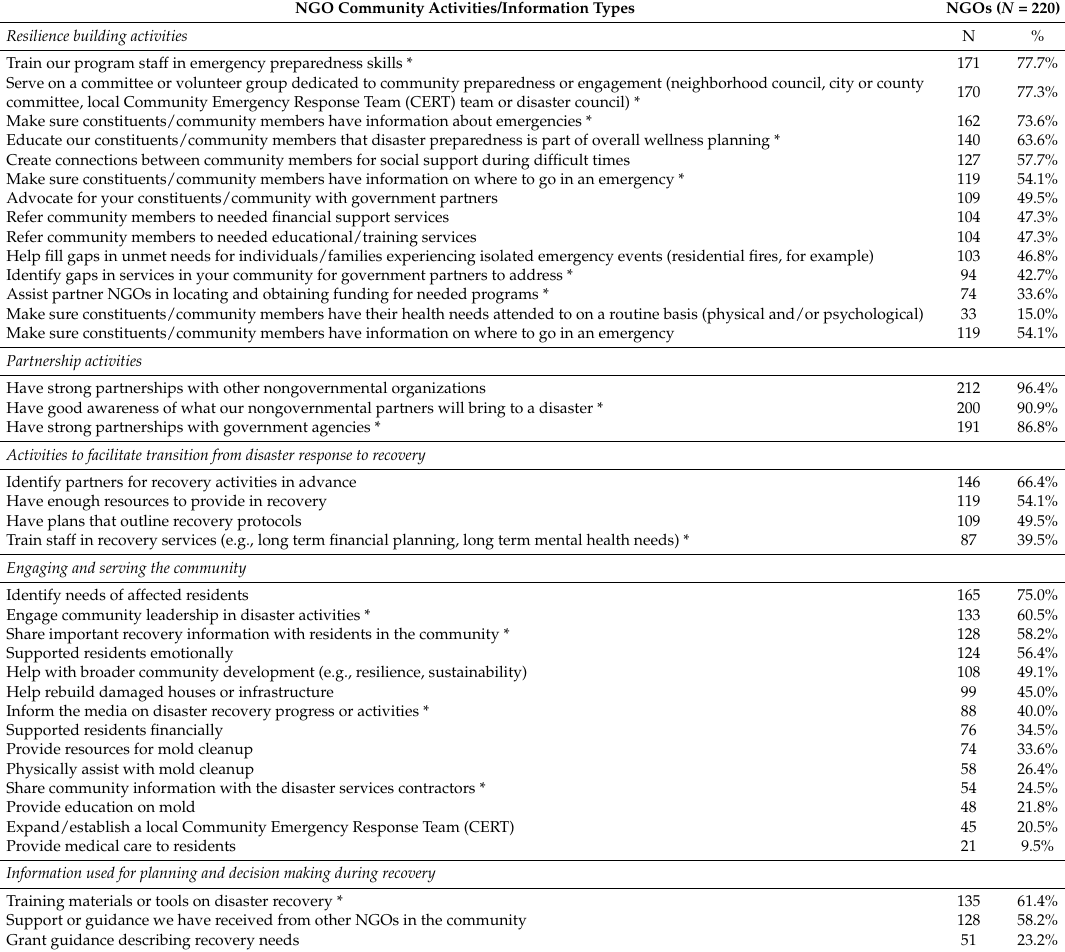
Table 1. Frequencies of nongovernmental organization (NGO) participation in community activities and information used for planning and decision-making during recovery ( N =